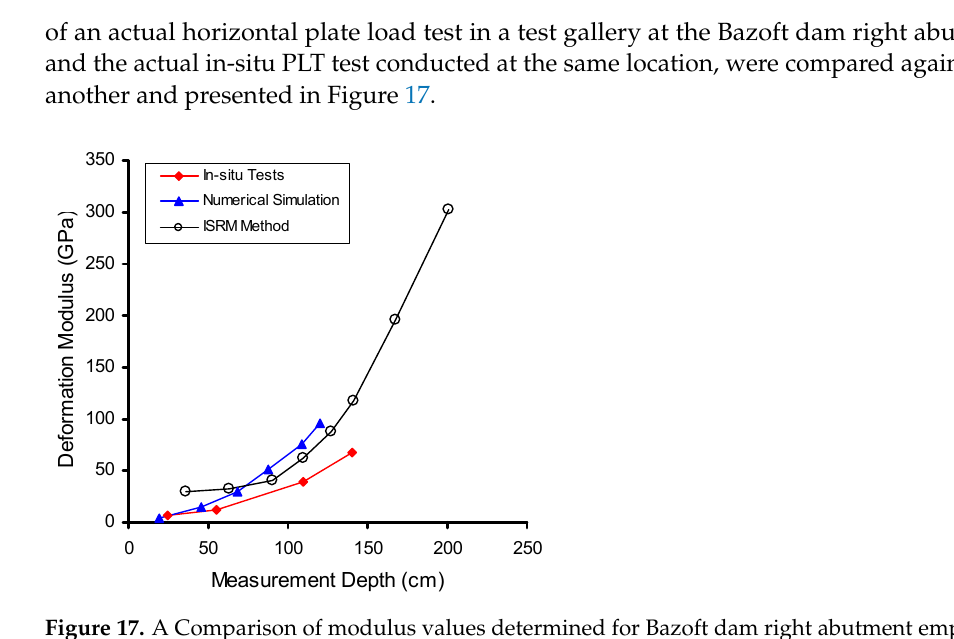
Figure 17. A Comparison of modulus values determined for Bazoft dam right abutment employing different methods.